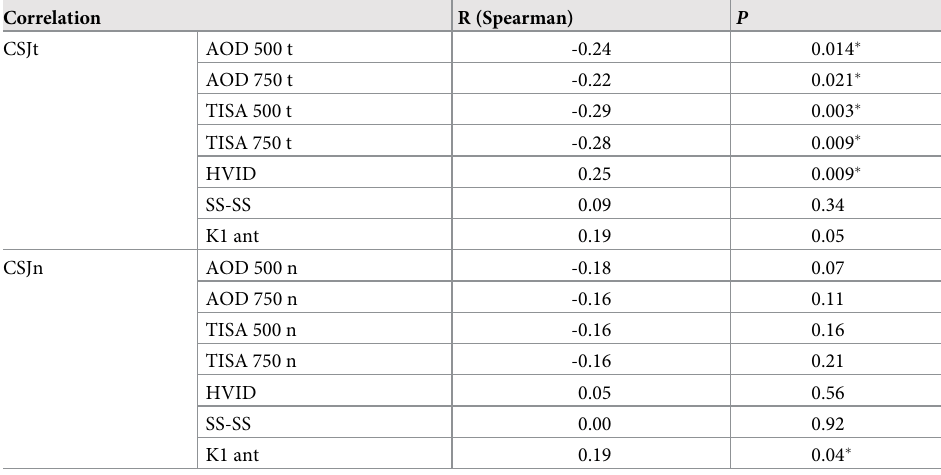
AOD = angle opening distance; CSJ = corneo-scleral junction; HVID = horizontal visible iris diameter; K1 ant = flat anterior meridian; TISA = trabecular space area; SS-SS = scleral spur to scleral spur distance; t = temporal; n = nasal. Statistically significant P values ( < .05) are marked with asterisk ( �